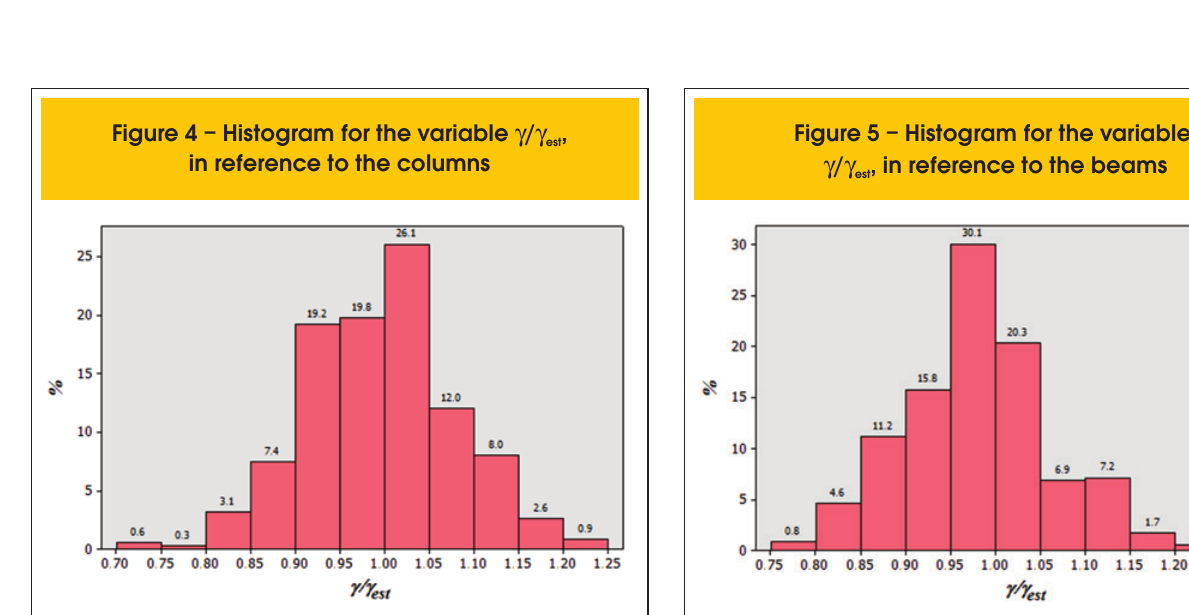
Figure 5 – Histogram for the variable g / g , in reference to the beams